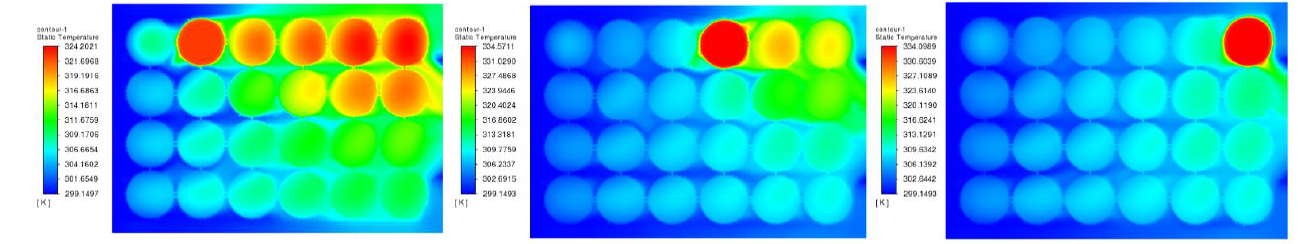
Figure 9. Comparison of the temperature distributions among the applied abnormal heat generation on different cells in Row 1.